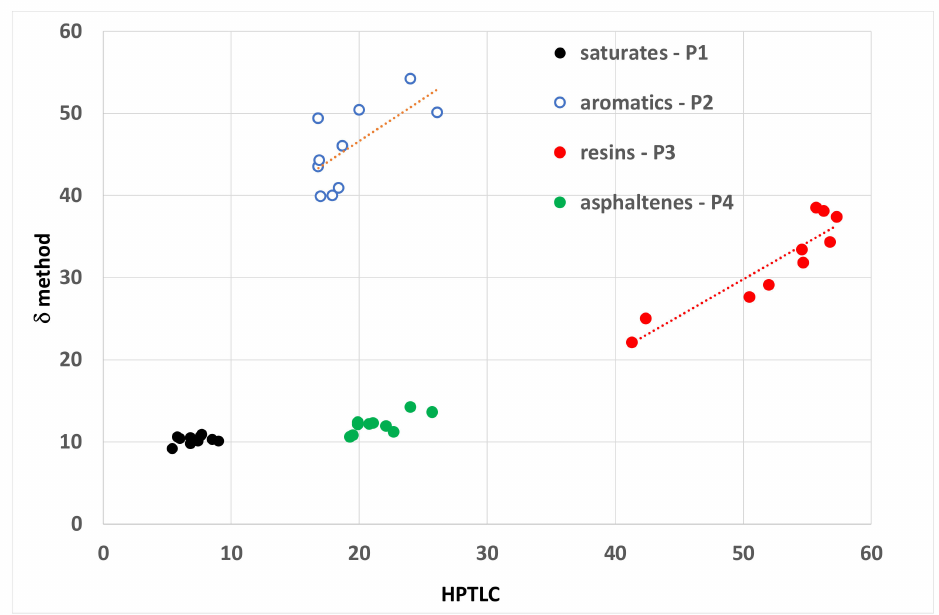
Figure 11. Comparison of the relative amounts (% by weight) of the four populations obtained by deconvolution and HPTLC. The red dotted lines represent the linear regressions for P2-aromatics and